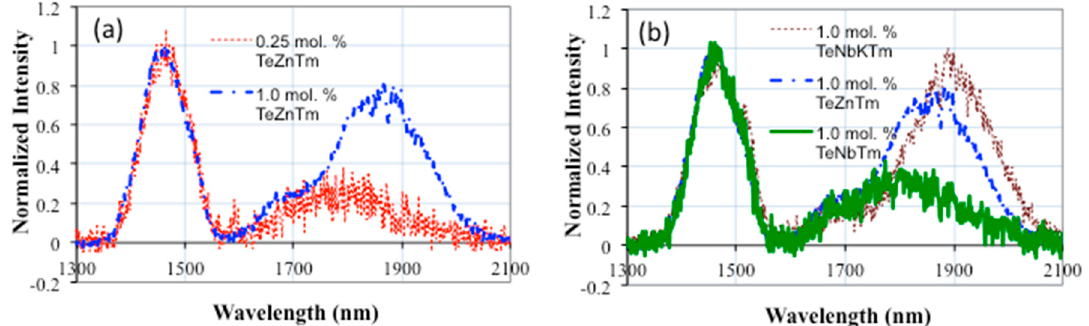
Figure 3. ( a ) Emission spectra of the two transitions of the Tm 3+ ion originating from 3 F 4 and 3 H 4 levels to the ground level for the glass host TeZnTm with Tm 2 O 3 concentrations of 1.0 and 0.25 mol %. ( b ) Emission spectra of the three glass hosts TeNbKTm, TeZnTm and TeNbTm, each with 1.0 mol % Tm 2 O 3 doping.